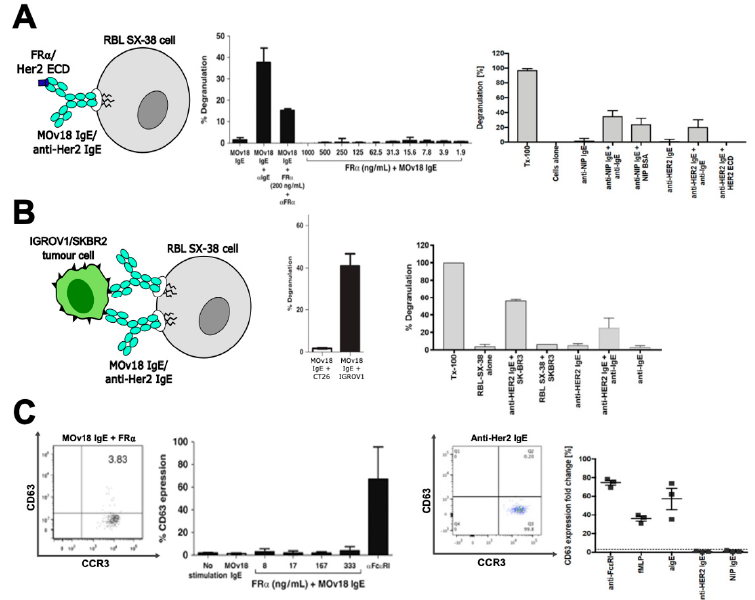
Figure 2. In vitro safety assessments of anti-cancer IgE antibodies. ( A ) RBL SX-38 mast cell degranulation was triggered by MOv18 and anti-Her2 (trastuzumab) IgE antibodies when